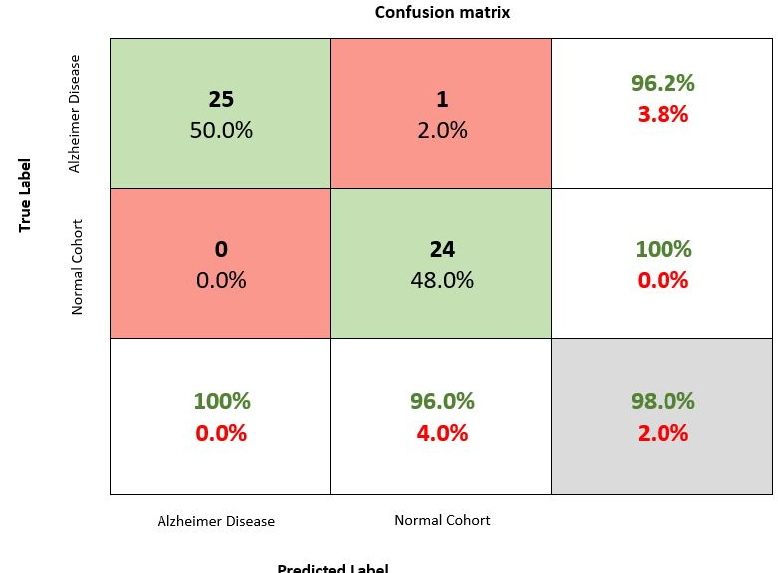
Figure 12. Confusion matrix.